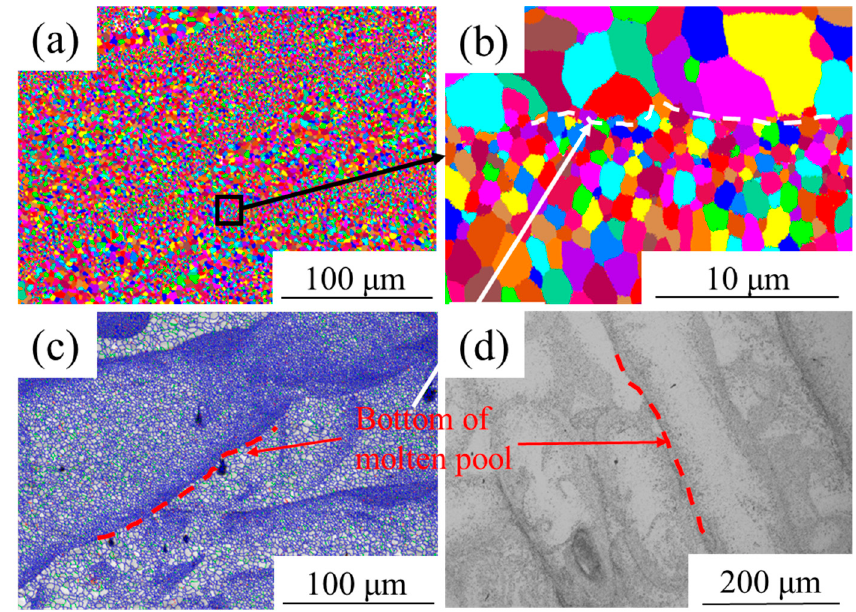
Figure 5. The metallographic structure and EBSD analysis of the horizontal section of sample 4 in the as-printed status, ( a ) grain reconstruction map, ×400, ( b ) grain reconstruction map, ×5000, ( c ) grain boundary reconstruction map, ( d ) metallographic photograph.